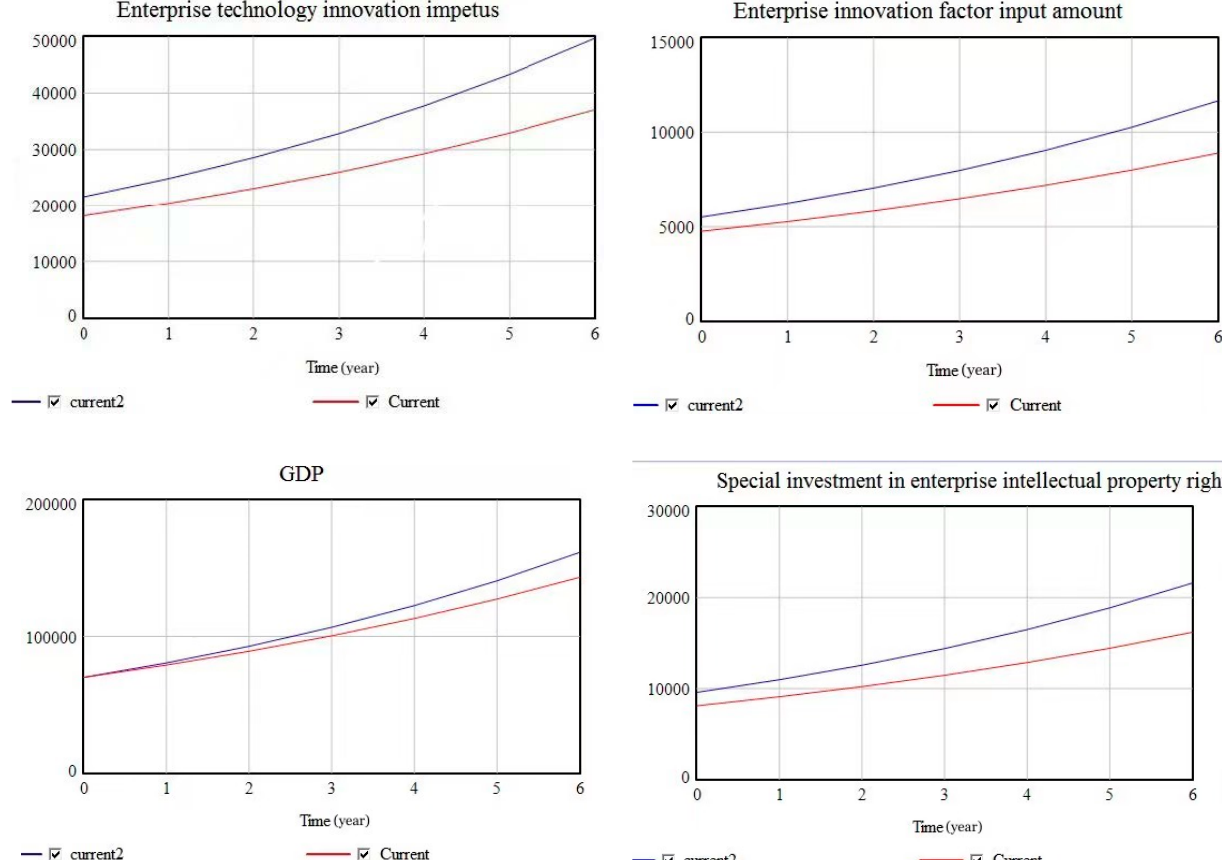
Figure 3. Sensitivity analysis of important indexes after constant value increased by 20%. (Note: In the above Figure 2, the horizontal axis represents the year, and the vertical axis represents the